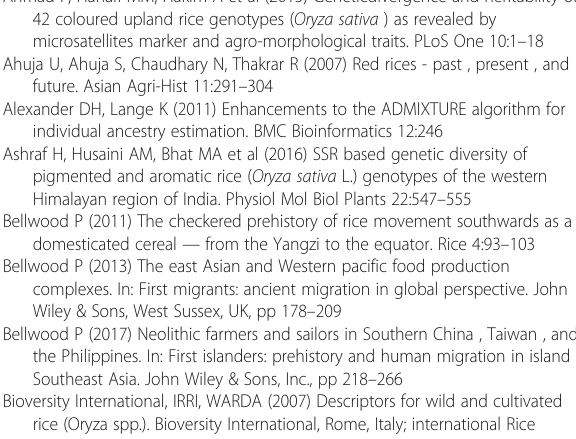
Additional file 2: Table S1. The 307 unique Philippine pigmented rice accessions used to assess genetic diversity. Table S2. Pairewise F ST comparison between rice varietal types and regions among the 307 unique accessions. Table S3. Pairewise F ST comparison between regions